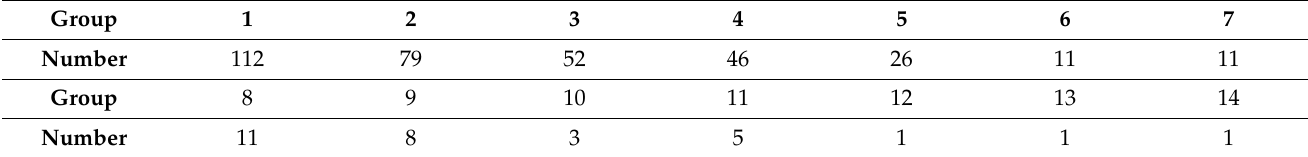
Table 1. The distribution of 367 data values of the freezing temperature of the